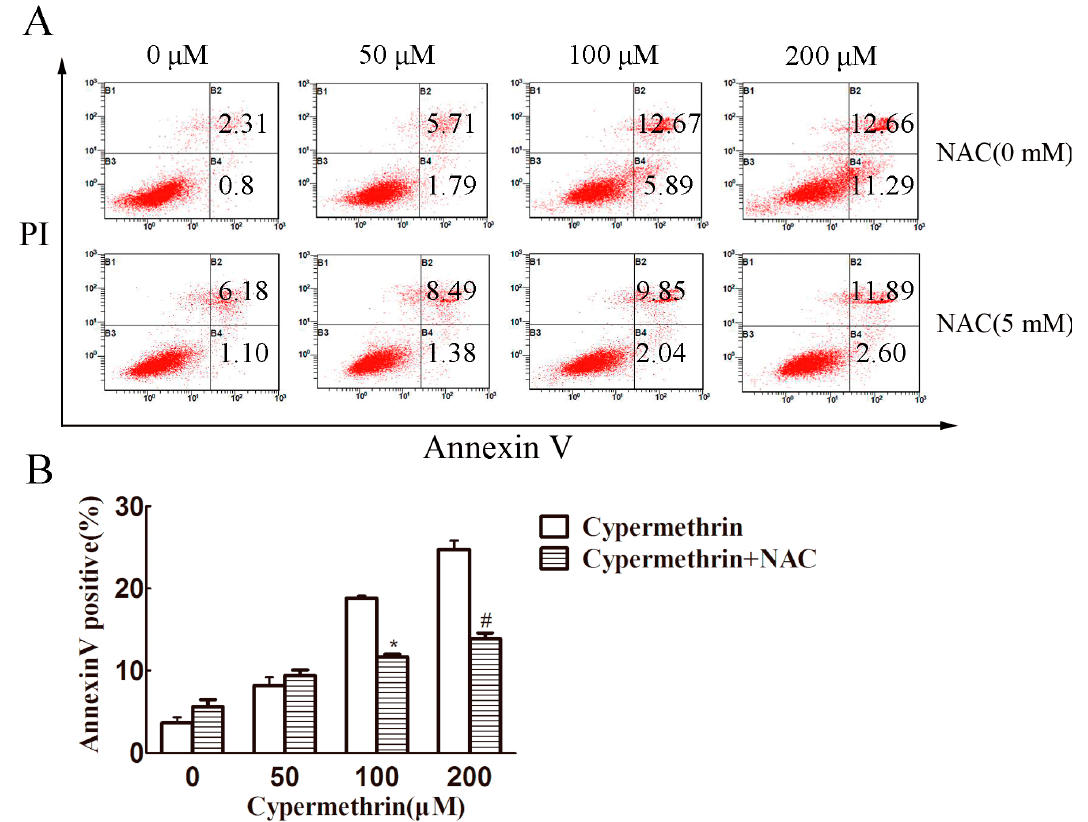
Figure 2. Cypermethrin induced apoptosis in RAW 264.7 cells. The cells were treated with cypermethrin in the presence or absence of 5 mM NAC for 48 h. In addition, the percentage of apoptotic cells was measured by Fluorescence Activating Cell Sorter (FACS) analysis using Annexin V/PI staining ( A ); Data were presented as means ± SD from three independent experiments ( B ). * p < 0.05 as compared with 100 μ M cypermethrin alone. # p < 0.05 as compared with 200 μ M cypermethrin alone.